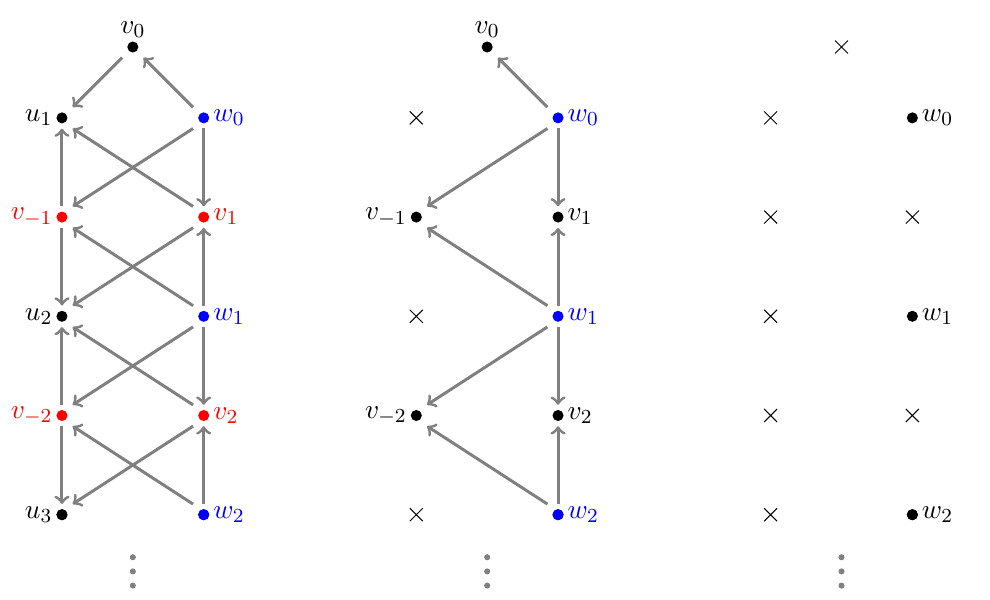
Figure 4 . Successive quotients of the Fock